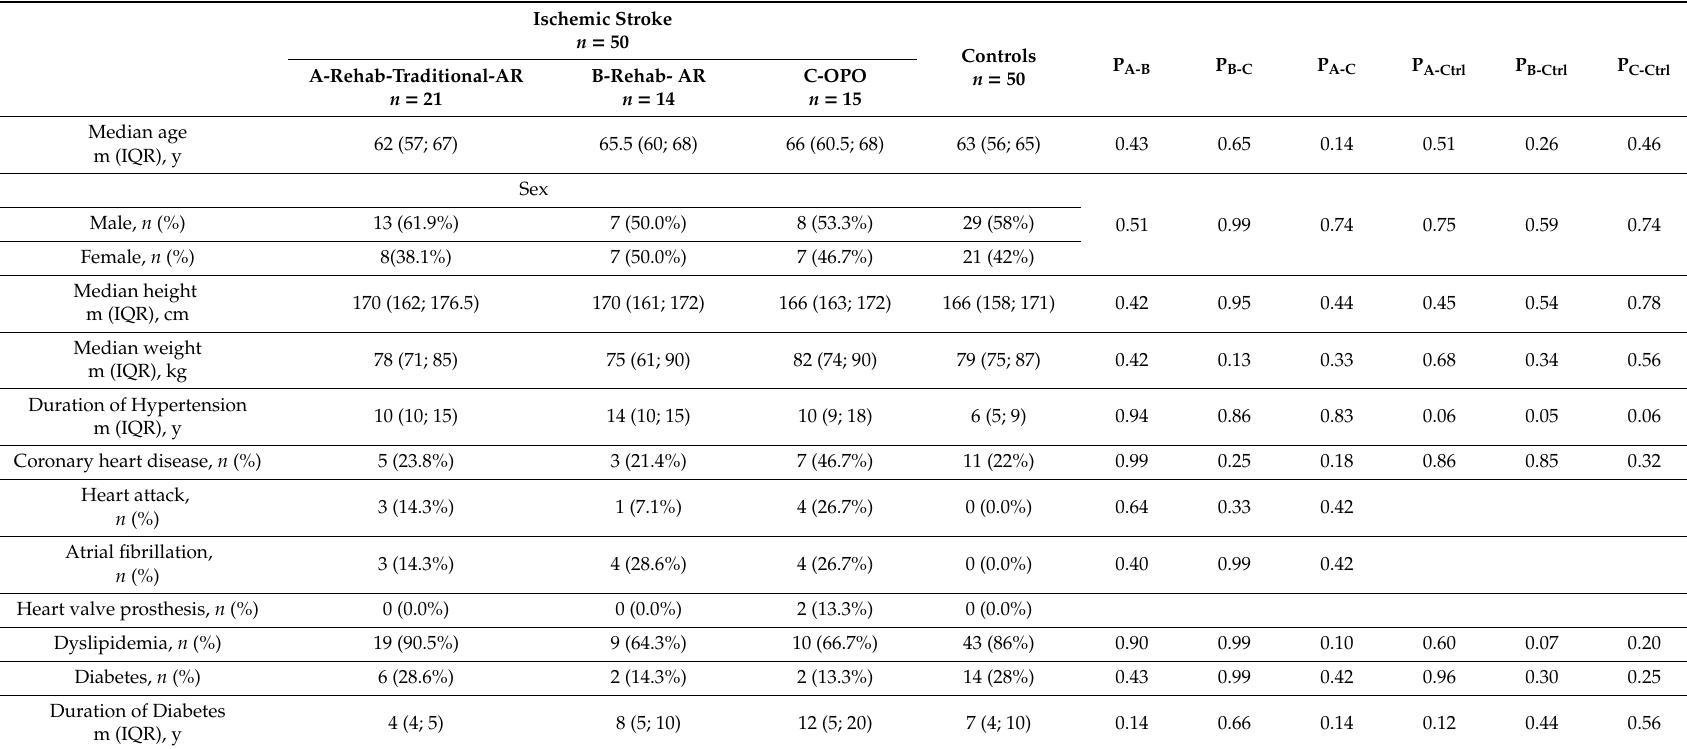
Table A1. Demographic and clinical characteristics of the patients and control